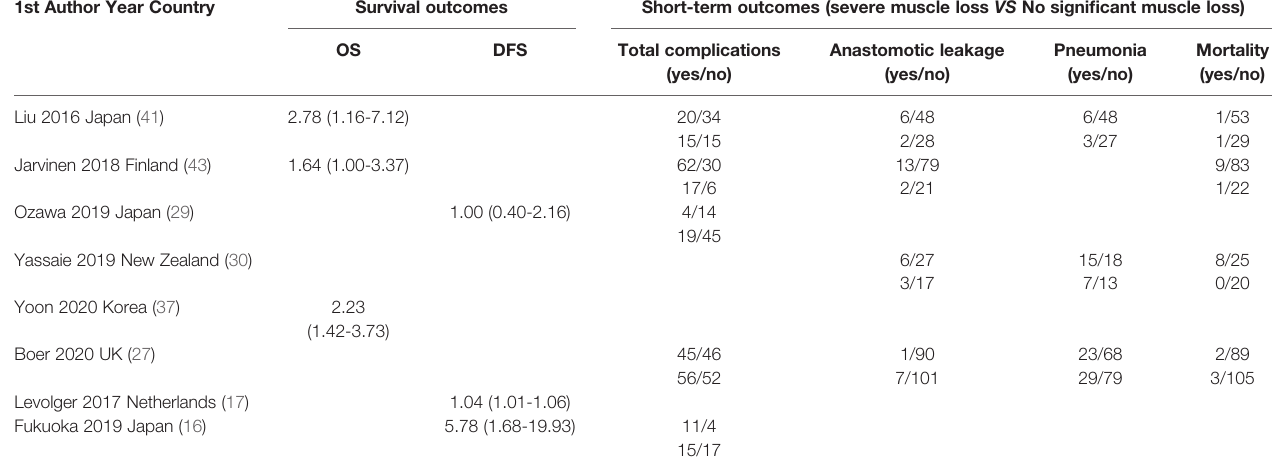
TABLE 3 | Main clinical outcomes included in meta-analysis (n =